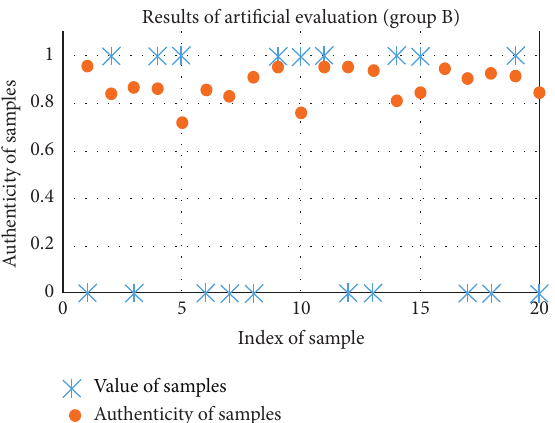
Figure 7: Qualitative evaluation results for Group B.